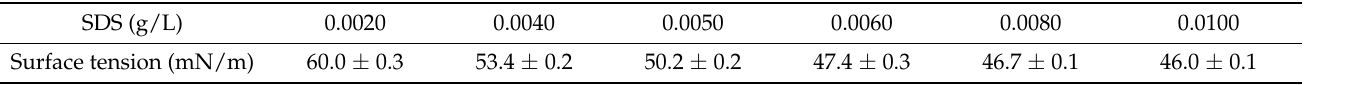
Table 1. Surface tension of the solution with different contents of sodium lauryl